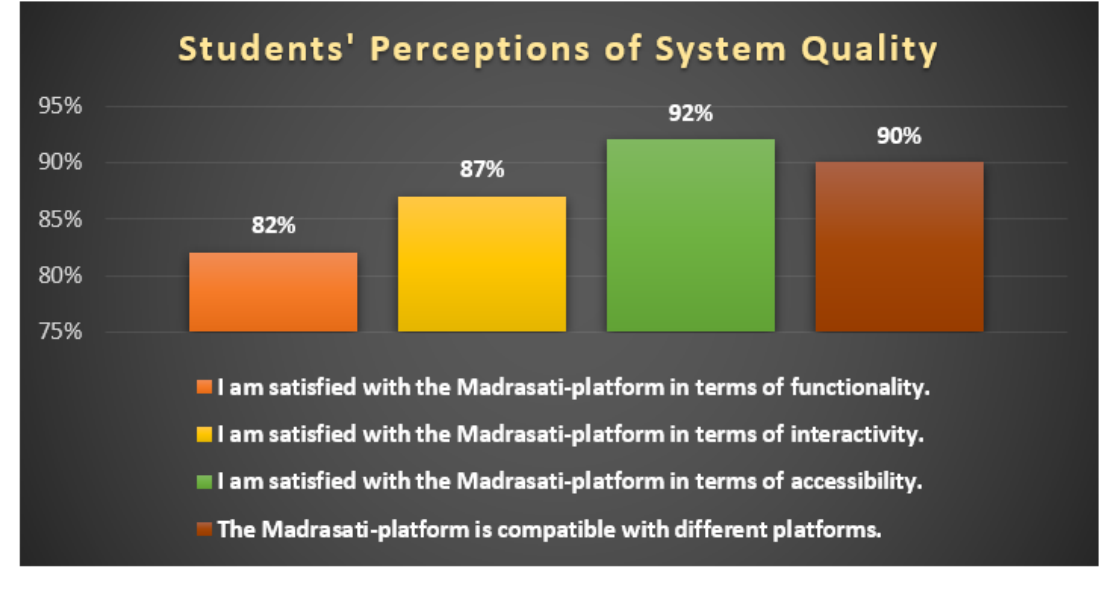
Figure 3. Students’ perceptions of SQ of the Madrasati platform.